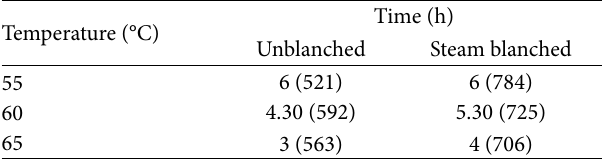
Table 1: Time, temperature combinations.